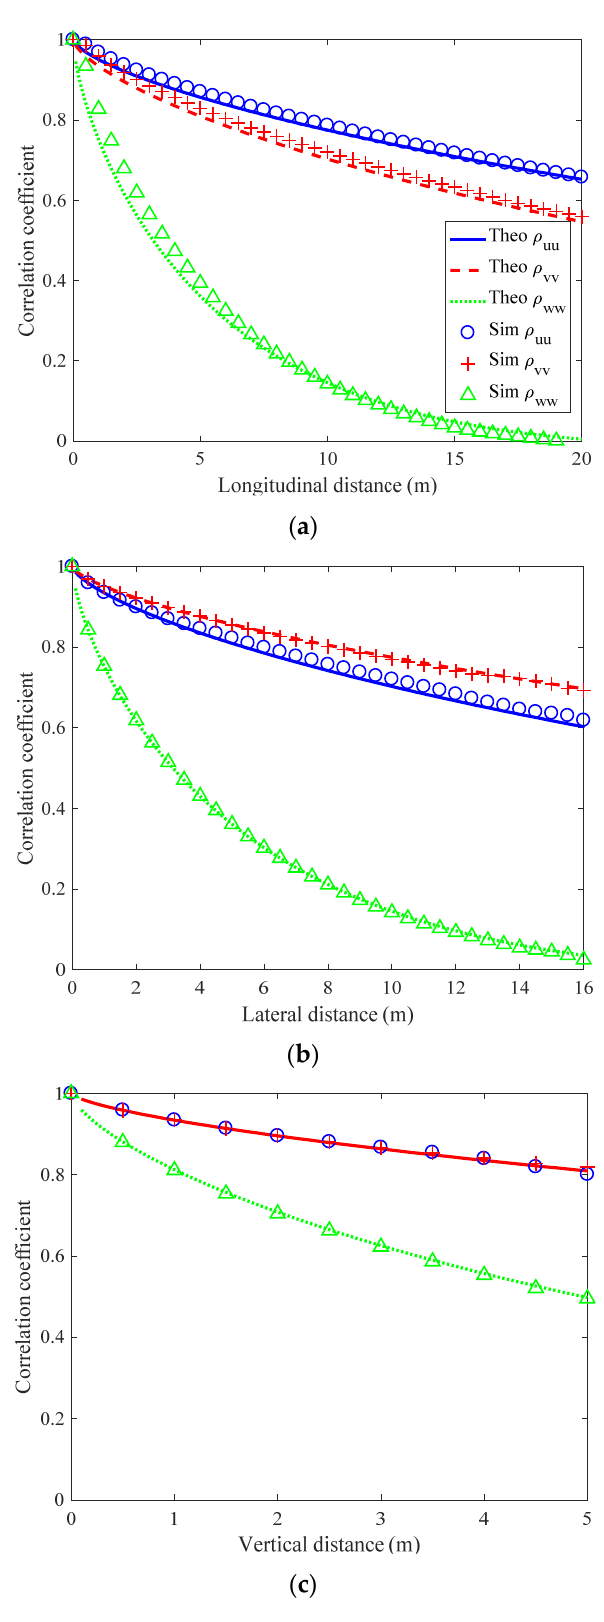
Figure 4. Comparison between simulated and theoretical correlation coefficients. ( a ) Along longitudinal direction; ( b ) Along lateral direction; ( c ) Along vertical direction.